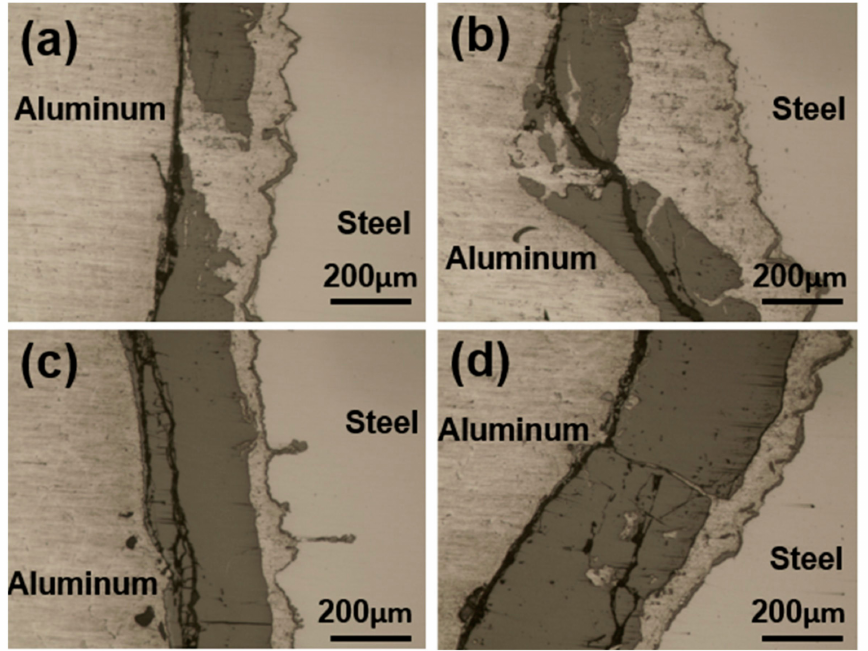
Figure 14. Interface micrographs of the bimetal gear with deformation degree of 90%: ( a ) position 1 (cid:13) , ( b ) position 2 (cid:13) , ( c ) position 3 (cid:13) , ( d ) position 4 (cid:13)